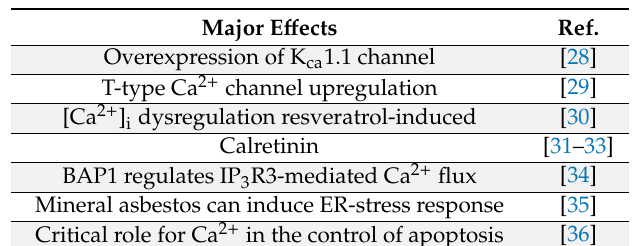
Table 1. Altered Ca 2 + toolkit in malignant